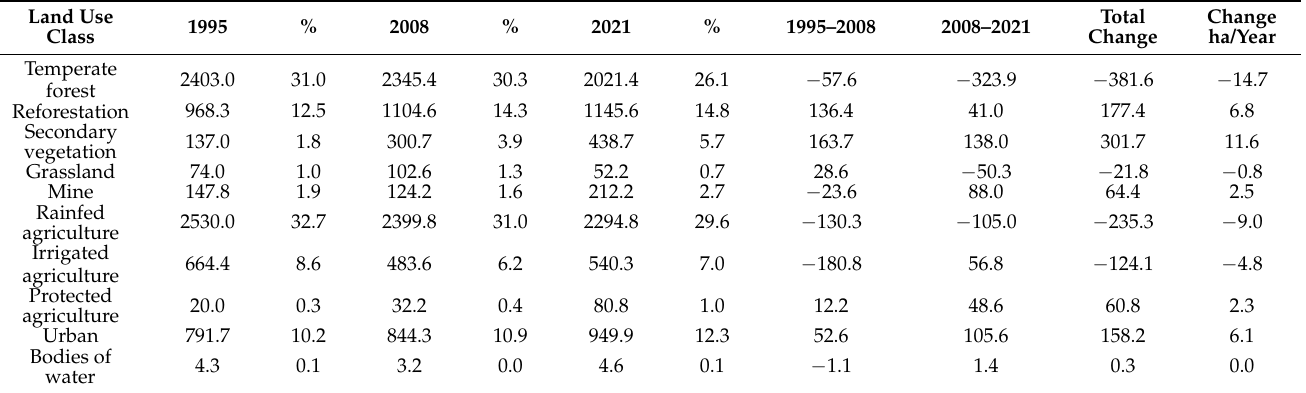
Table 4. Area (hectares) of the land use and vegetation classes in 1995, 2008, and 2021 and the trends of change between 1995–2008 and